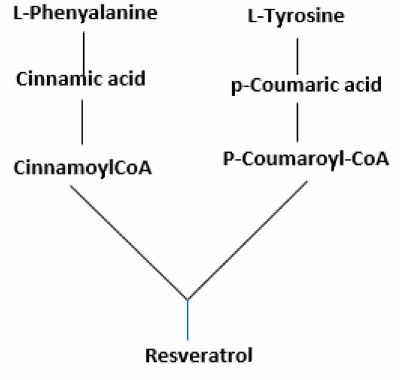
Figure 2. Secoiridoids biosynthesis [33].